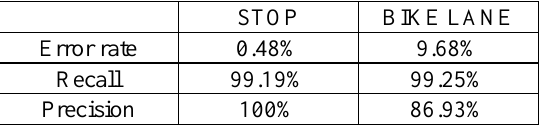
Table 1.Xi-alpha estimates for STOP and BIKE LANE signs